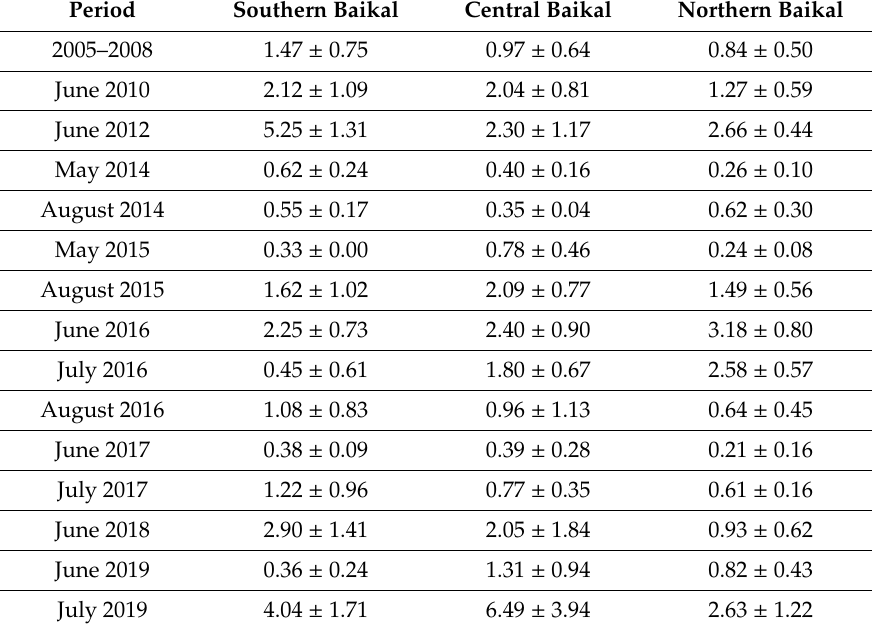
Table 3. Variability of the average concentrations the sum of ions in the atmospheric aerosol of the near-water atmosphere above Lake Baikal in the warm season from 2010 to 2019, µ g / m